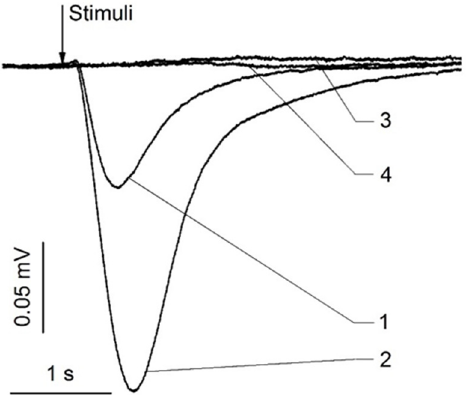
Figure 5. Representative electroolfactogram recordings from rat olfactory and respiratory epithelia.